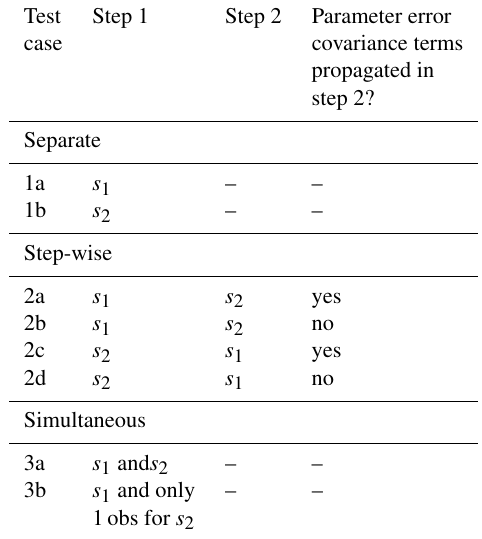
Table 2. List of experiments performed for both models with syn- thetic data. All parameters are optimised in all cases (therefore in both steps for the step-wise